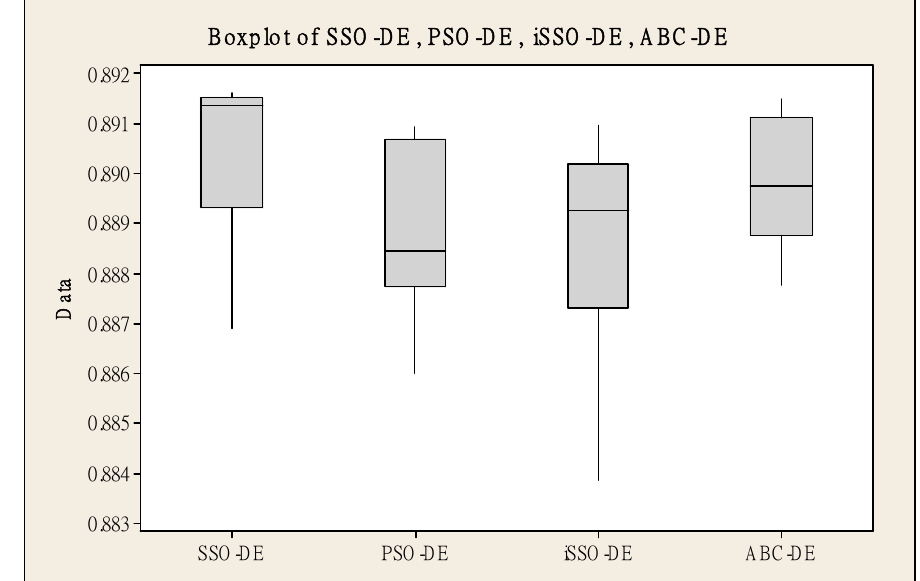
Figure 10. Box and whisker diagram for spring (autumn).